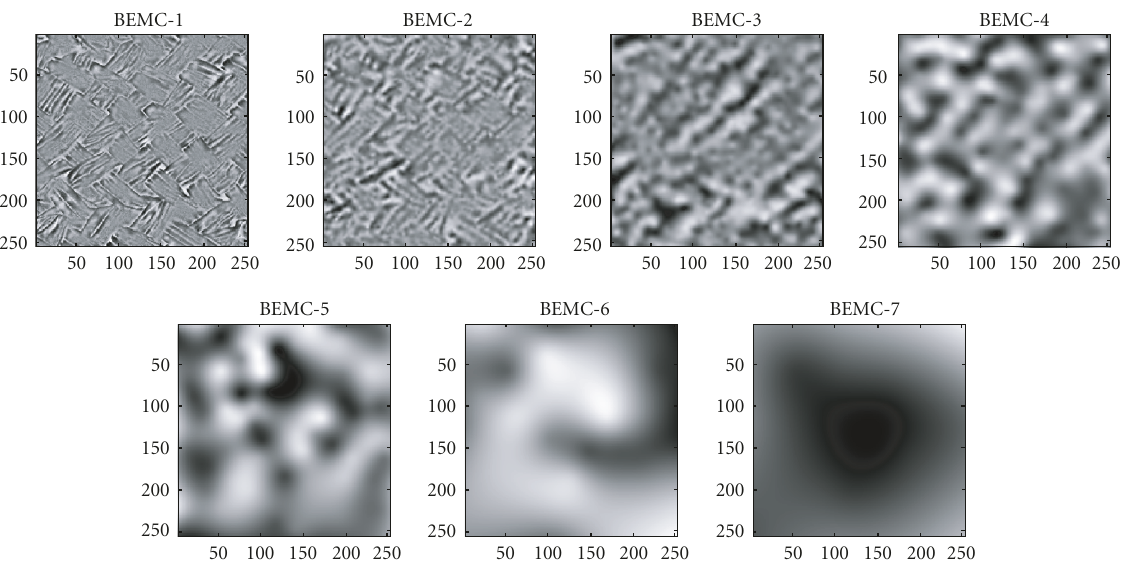
Figure 20: BEMCs of D18 image obtained by BEMD with RBF-TPS (MNAI = 10).